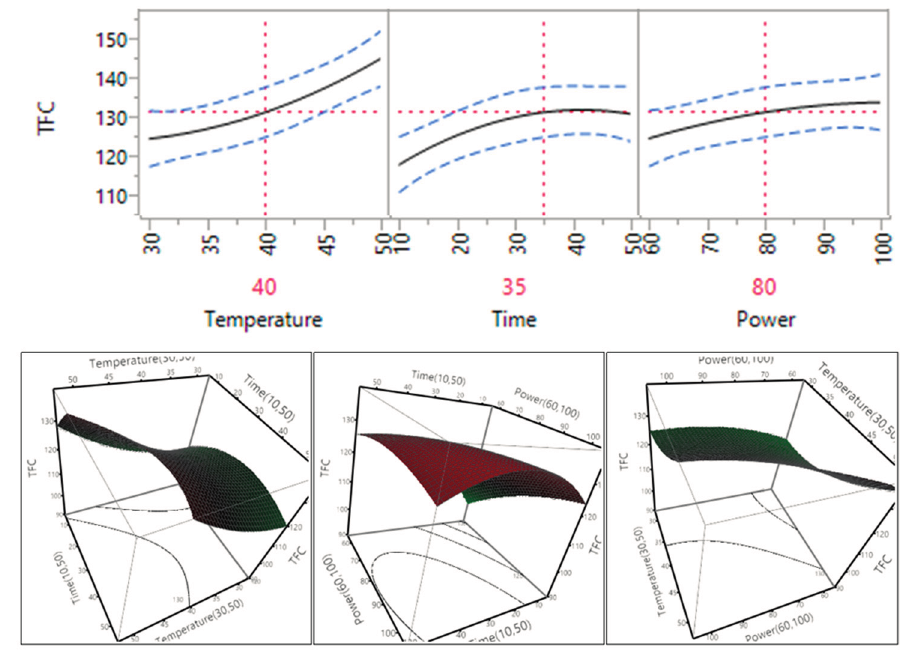
Figure 5. Impact of temperature (60–90 °C), time (10–30 min) and power (60%–100%) on flavonoids (mg